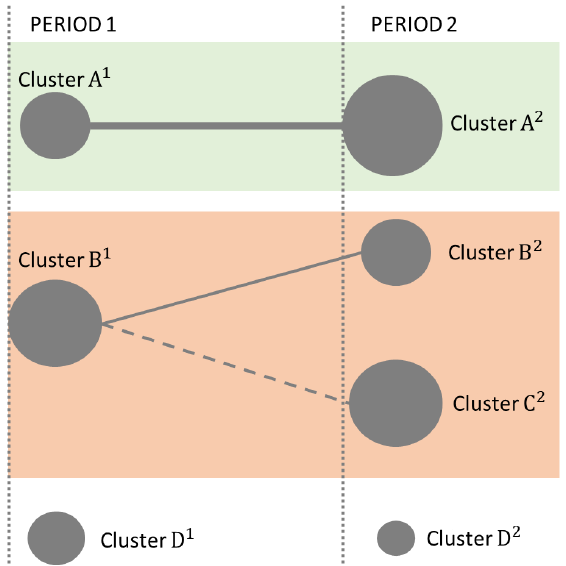
Figure 3. Thematic Evolution. Source: Cobo